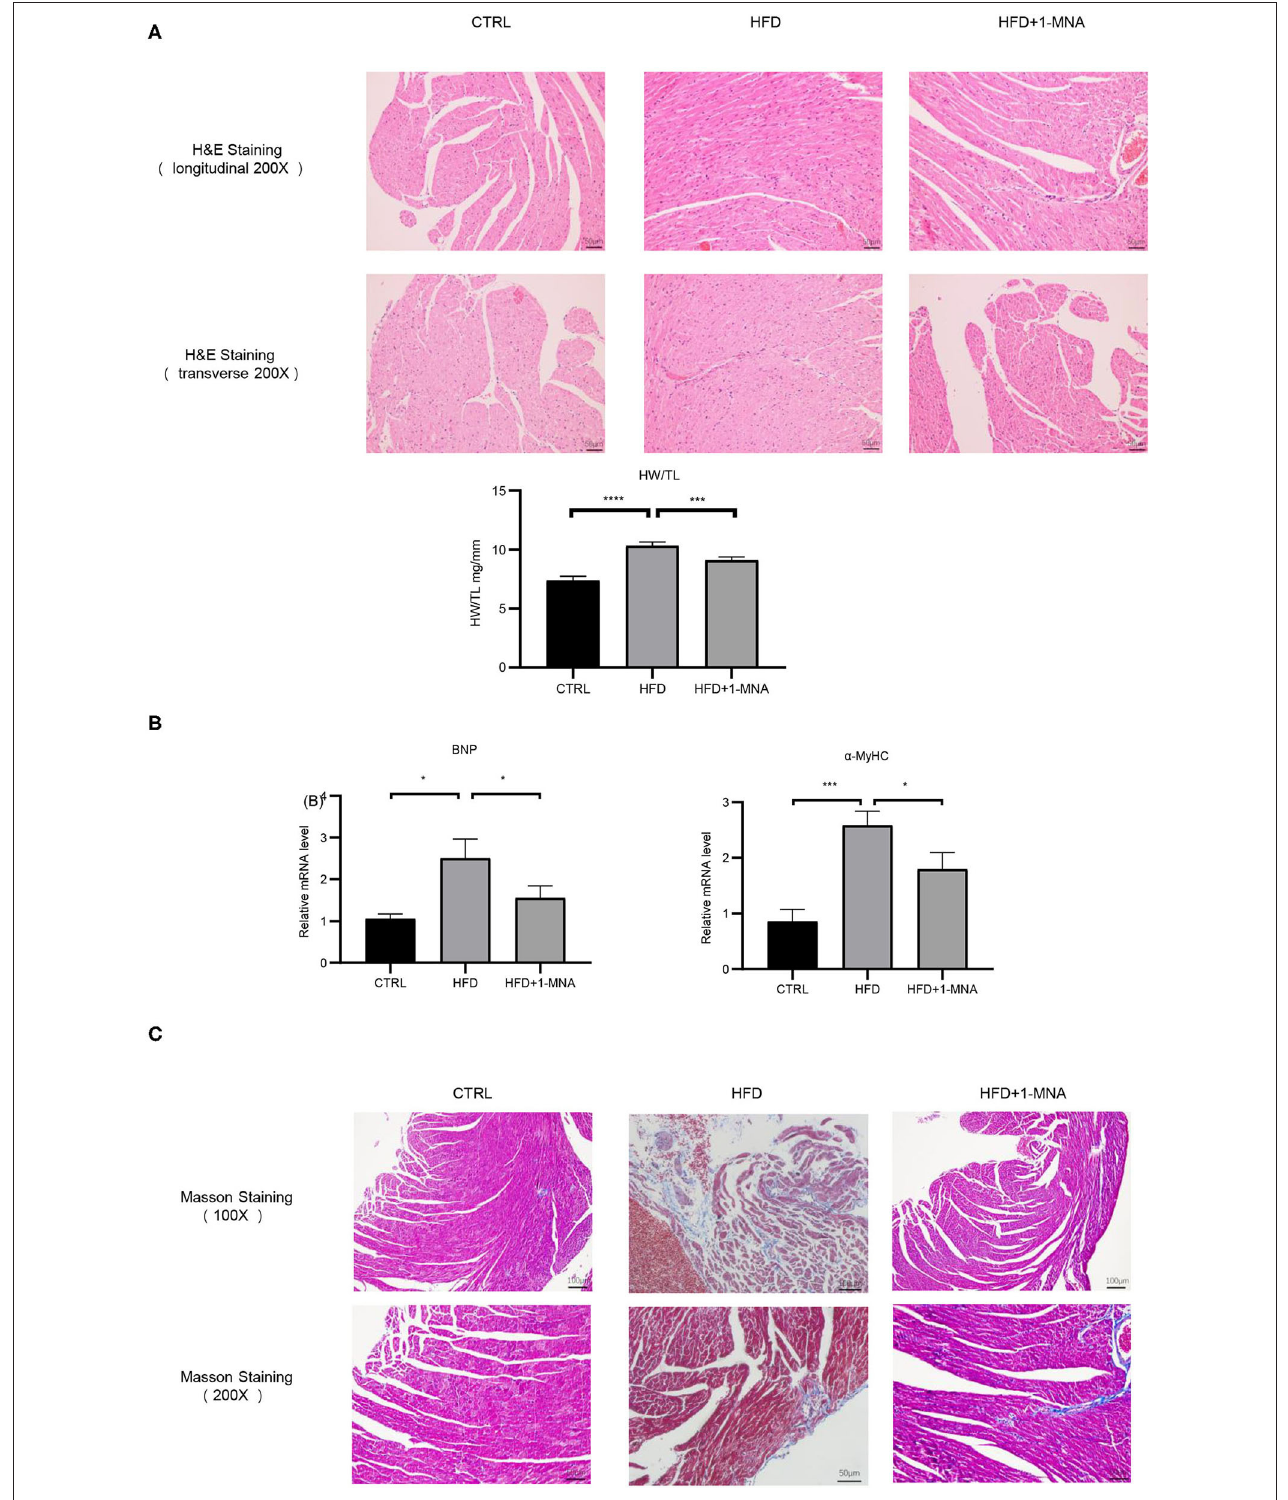
FIGURE 7 | 1-MNA amileorated HFD-induced heart injury. (A) Representative images from longitudinal and transverse H&E staining of heart tissues are shown. Data for the ratio of heart weight (HW) to tibia length (TL). (B) 1-MNA administration reduced the indicated gene expression in HFD-induced hearts. (C) Myocardial tissue was colored in red and collagen was colored in blue by Masson staining. Under light microscopy, the myocardial fibers of the control group were arranged neatly, with no obvious breaks or rearrangements. The size of the intercellular space was normal. ( n = 5, * P < 0.05, *** P < 0.001, **** P < 0.0001).